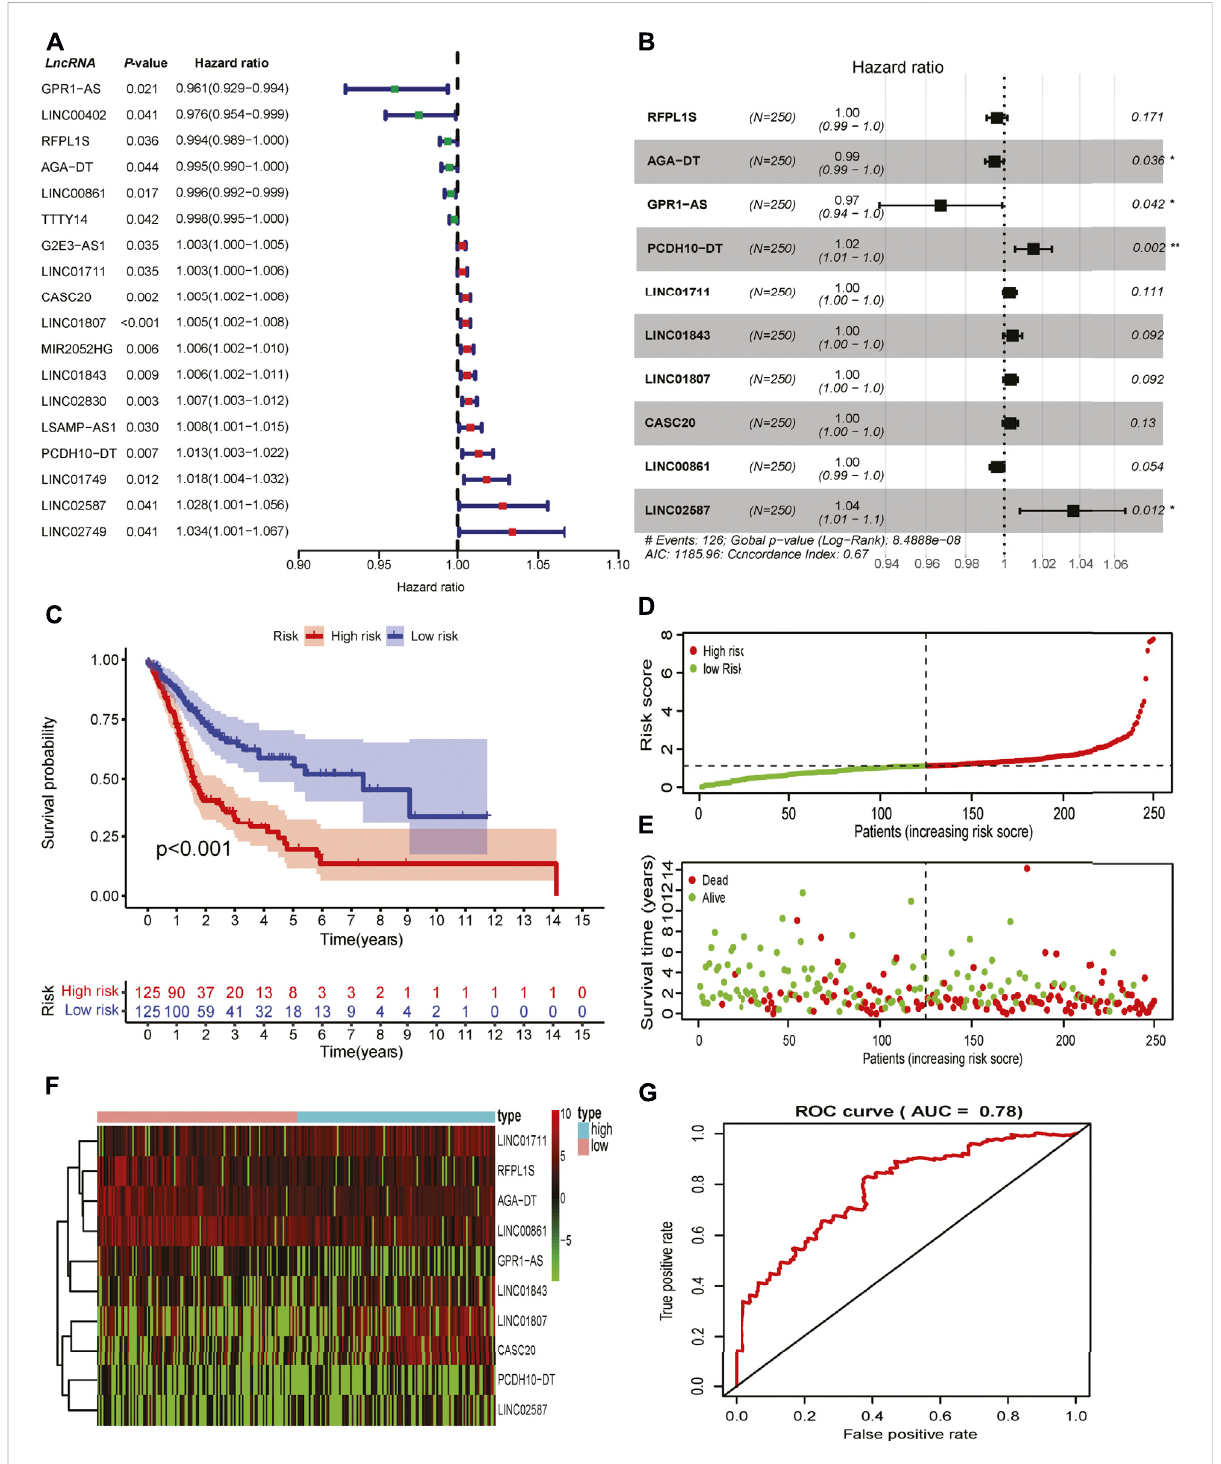
FIGURE 2 Development of genomic instability-related prognostic signature. (A) Identi fi cation of overall survival-associated GI-related lncRNAs in the training set in HNSCC. (B) The lncRNAs and their coef fi cients of the prognostic signature were developed by Lasso-Cox regression analysis. (C) The Kaplan – Meier curveofpatients inhigh- and low-risk groups inthetraining set. (D) Thecorrelationof thenumberof patients ’ deaths withrisk scores. (E) Thecorrelationofthenumberofpatients ’ overallsurvivalwithriskscores. (F) TheexpressionoflncRNAscomprisedthesignatureinthehigh- andlow-risk groupsinthetrainingset. (G) Time-independentreceiveroperatingcharacteristiccurveofthesignatureinthetrainingsetcalculatedby the area under the